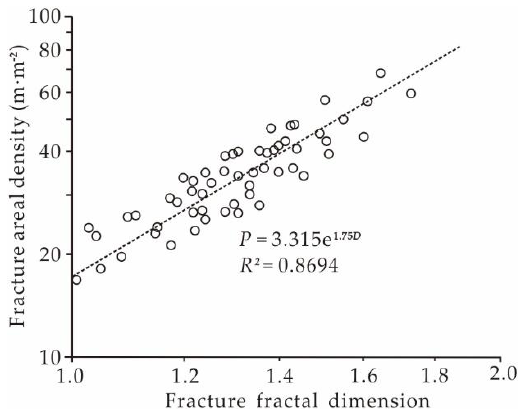
Figure 9. Relationship between fractal dimension and fracture areal density.